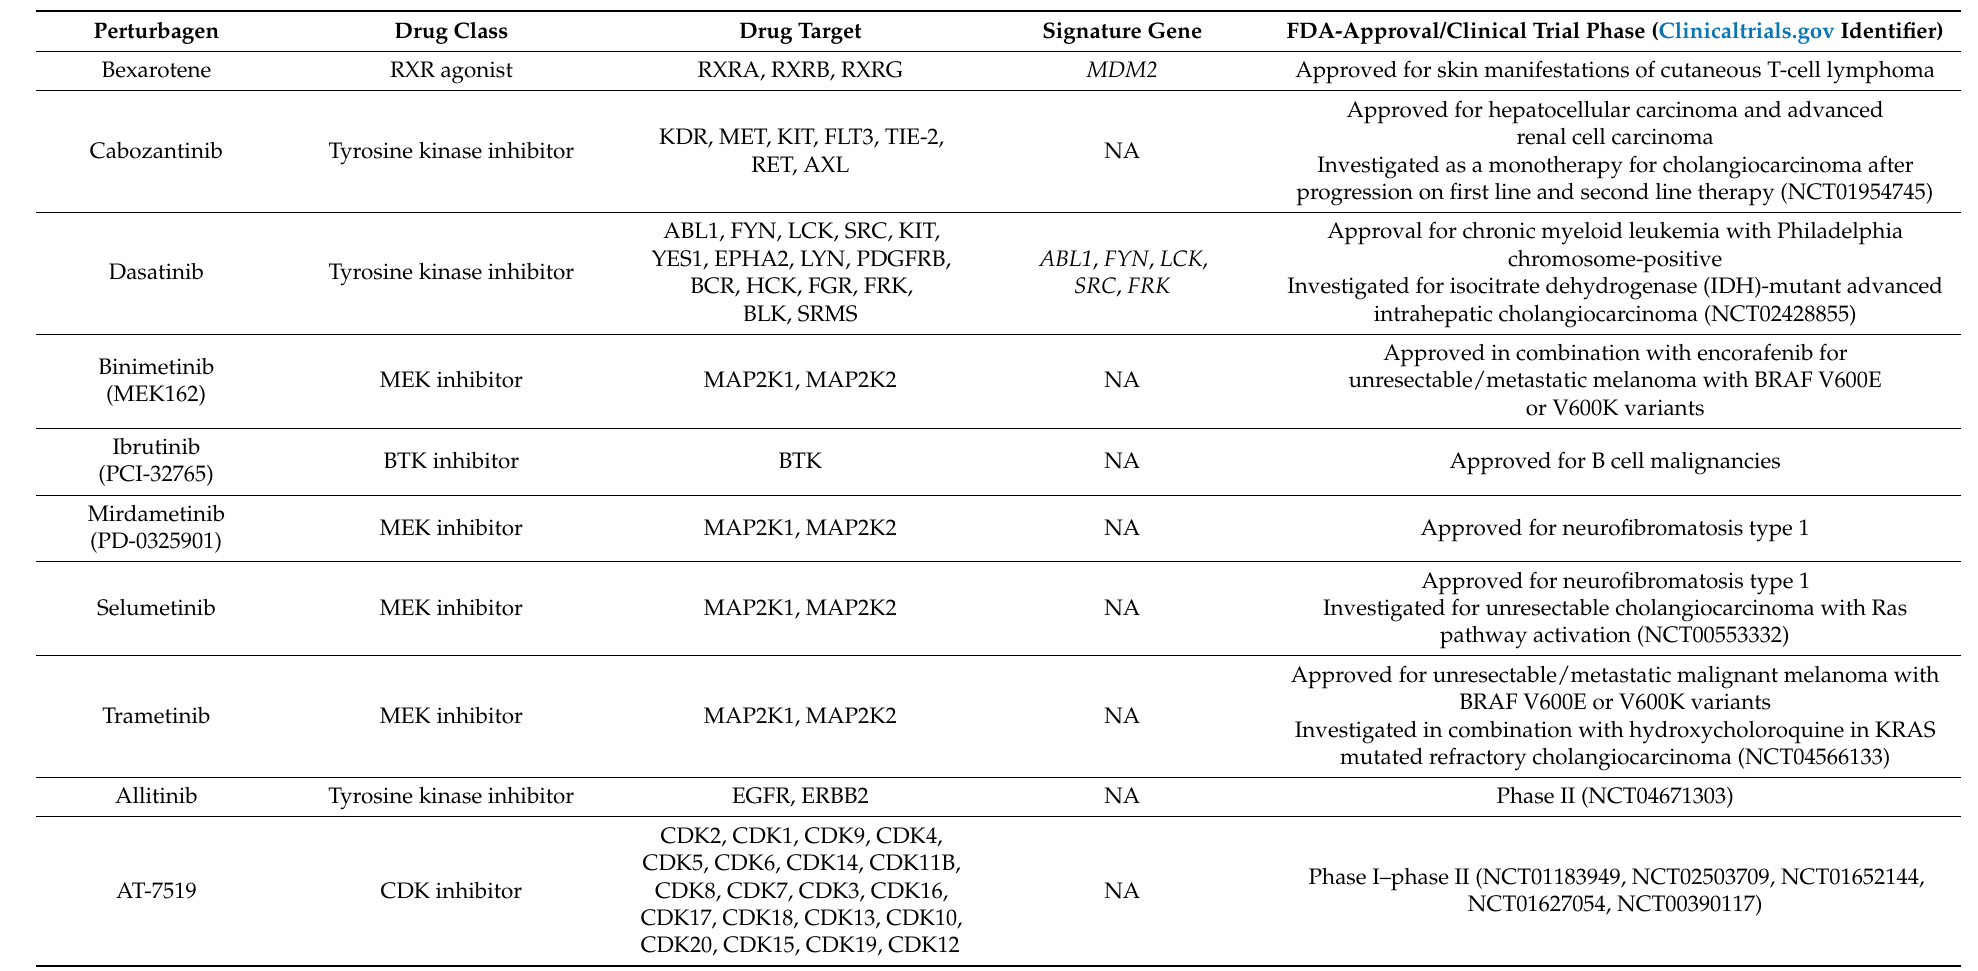
Table 1. Candidate drugs predicted to have therapeutic efficacy in the CCA patient subpopulation with the high-expression of the immune-oncogenic gene signature in tumor tissues. NA, not